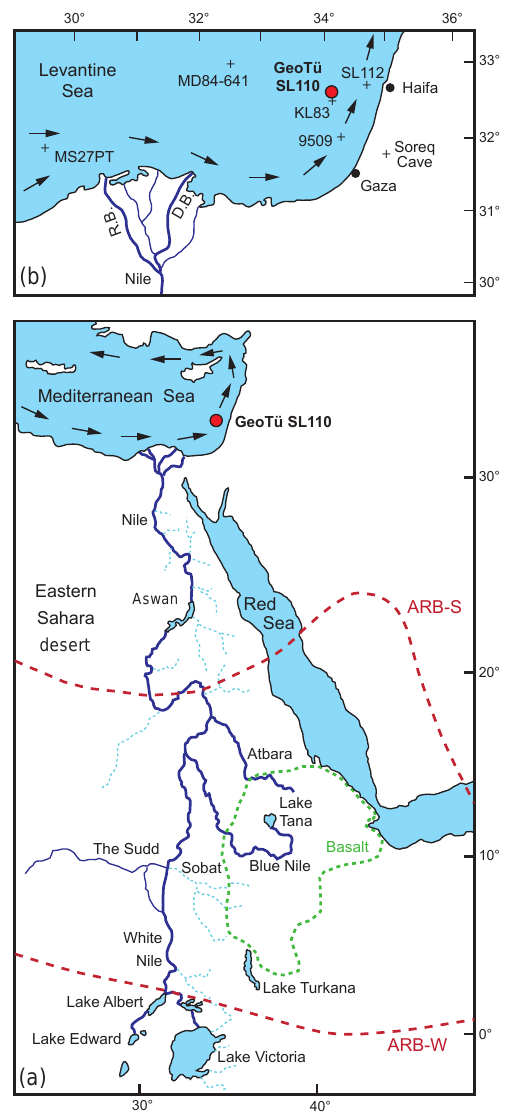
Figure 1. Location map of the Nile River basin and the eastern Mediterranean Sea. Panel (a) : the Nile River and its main tribu- taries. Blue dashed lines indicate wadis. The green dotted line shows the main outcrop of Cenozoic basalts in Ethiopia. Also shown are the northern summer and winter limits of the African rain belt (red dashed lines; ARB-S, ARB-W, after Blanchet et al., 2014). Black ar- rows in the eastern Mediterranean Sea indicate the surface currents (after Pickard and Emery, 1990). Panel (b) : map of the southeastern Levantine Sea with the location of the investigated sediment core GeoTü SL110 and other cores mentioned in the text; not shown are GeoTü SL143 and LC21, which are positioned further to the north (cf. Table 1). D.B.: Damietta branch of the Nile in the delta; R.B.: Rosetta